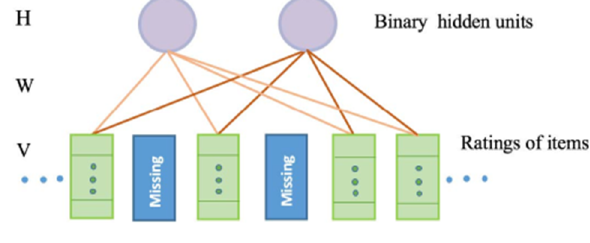
Figure 9. RBM Neural Network.